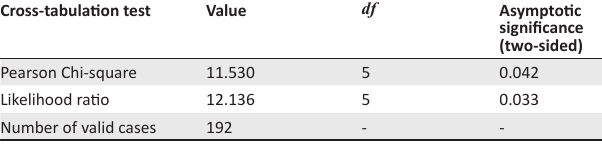
TABLE 4b: Chi-Square